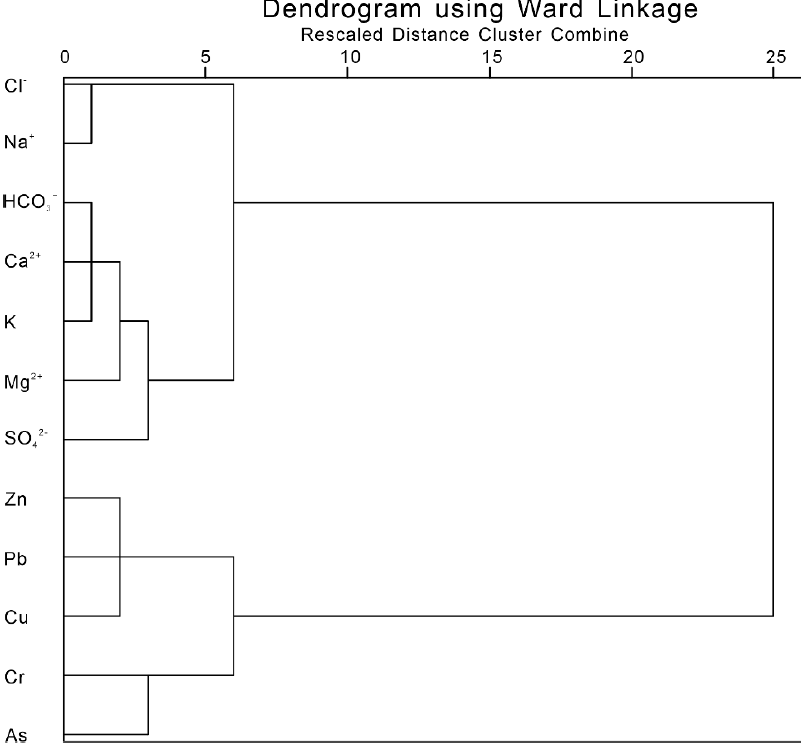
Figure 5. Hierarchical clustering analysis of major ionic and dissolved heavy metal elements in the river waters from Issyk − Kul Lake Basin during the period with high river flow.